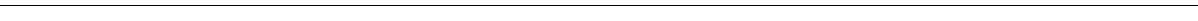
Figure 5 | Computer modelling reveals Ase1 essential role in spindle formation. ( a ) Schematic of Ase1 effects. Ase1 (black) crosslinks antiparallel MTs (green, purple) and promotes MTalignment and bundling. ( b ) Model schematic. The NE (grey sphere) contains mobile but membrane-bound SPBs (blue). MTs (green, purple) are tethered to SPBs. Ase1 molecules (black) diffuse within the volume enclosed by the NE and can attach to and move along MTs. ( c ) Schematic of SPBs and MTminus ends. MTs are tethered via springs to SPBs. ( d ) Image sequences of spindle assembly simulation. Initially the SPBs are adjacent, and each MT is 0.1 m m long (t ¼ 0). Black spheres/lines indicate unbound/bound Ase1 molecules, which initially diffuse in the nucleoplasm. Times shown are in minutes and seconds. A bipolar spindle forms, elongates and remains stable through the end of the 10-min simulation. ( e ) Image sequences of spindle assembly with increased Ase1 number. ( f ) Image sequences of spindle assembly simulation that mimics Cls1 deletion. Ase1 molecules are present and can crosslink antiparallel MTs, but Ase1 does not cause stabilization of MTdynamics. Spindle assembly does not occur. ( g ) Quantification of multiple simulations using the parameters of d – f , showing SPB separation as a function of time. ( h ) Frequency of bipolar spindle assembly for randomly sampled parameter sets with and without stabilization of MT dynamics by crosslinking. ( i – n ) Dependence of spindle assembly and length on single varied parameters. ( i ) Number of Ase1 molecules, ( j ) wall force, ( k ) catastrophe frequency, ( l ) rescue frequency, ( m ) rescue frequency stabilization, ( n ) shrinking speed stabilization. Note that in i and j the number of simulations corresponding to each point is indicated by the colour of the point, as shown in the colour bar. Data show mean ±